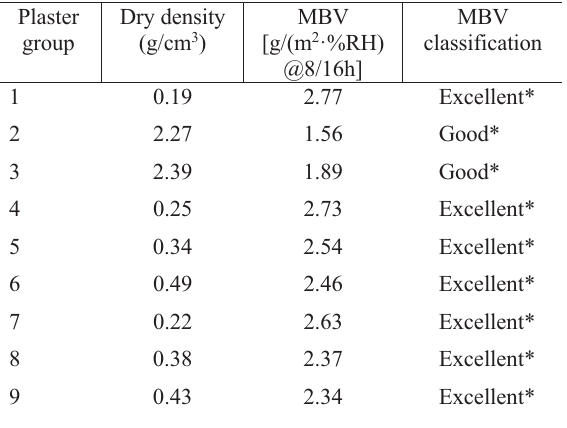
Table 2. Density and MBV of